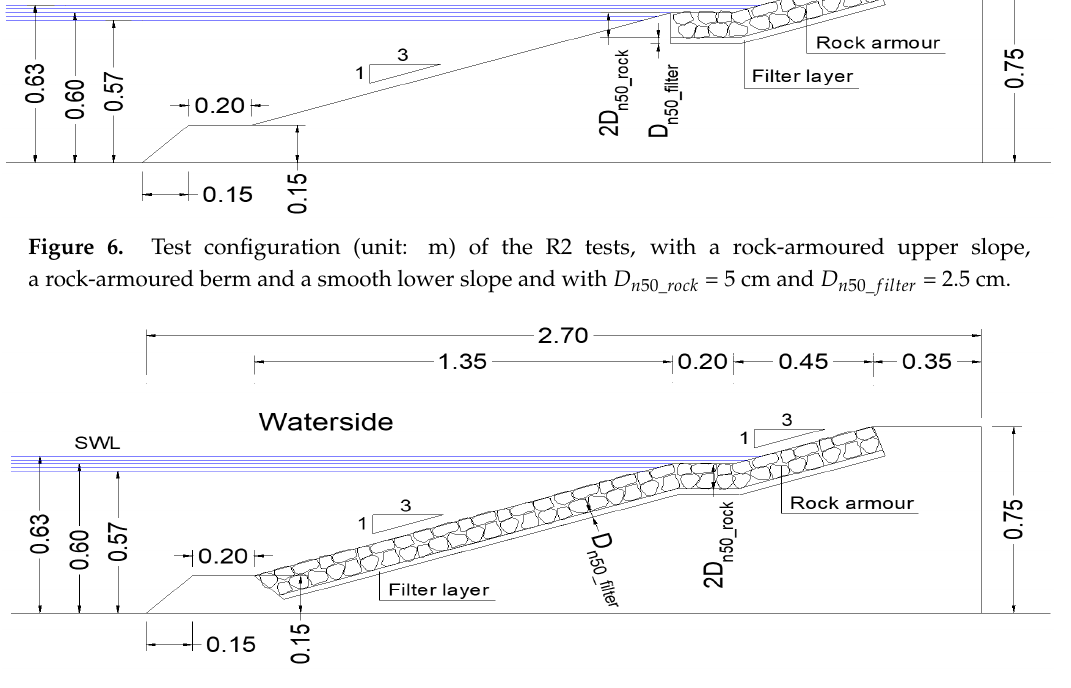
Figure 7. Test configuration (unit: m) of the R3 tests, with the entire slopes and a berm covered by rock armour and with D n 50_ rock = 5 cm and D n 50_ filter = 2.5 cm.